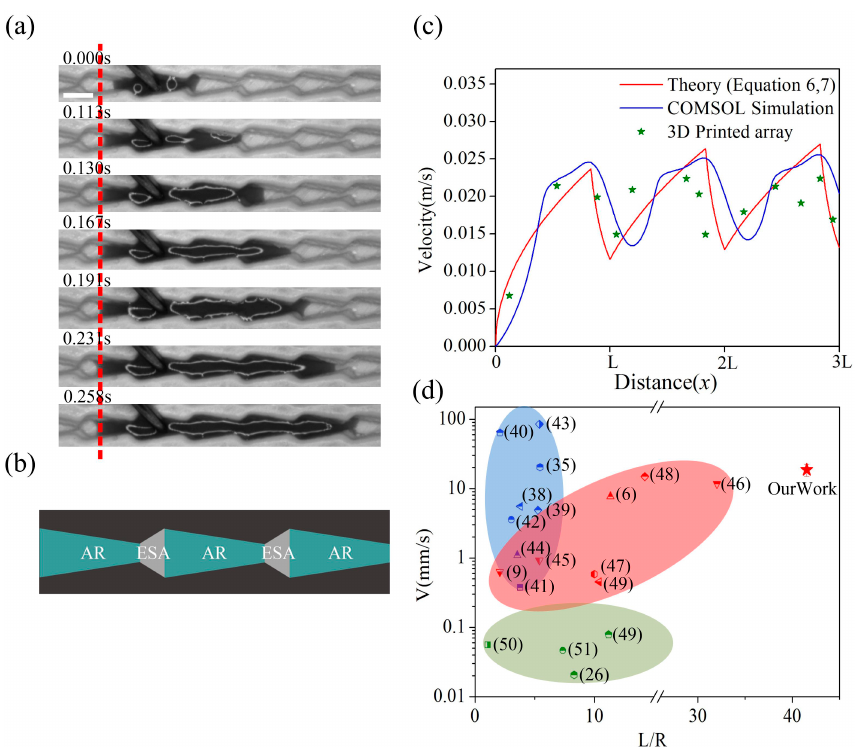
Figure 6. ( a ) Liquid transport process captured with a high-speed camera (scale bar = 1 mm). ( b ) Classification of different regions within the arrowhead microstructure. ( c ) Fitting of theory, simulation, and experimental data. ( d ) A comparison of our work to that available in the literature..